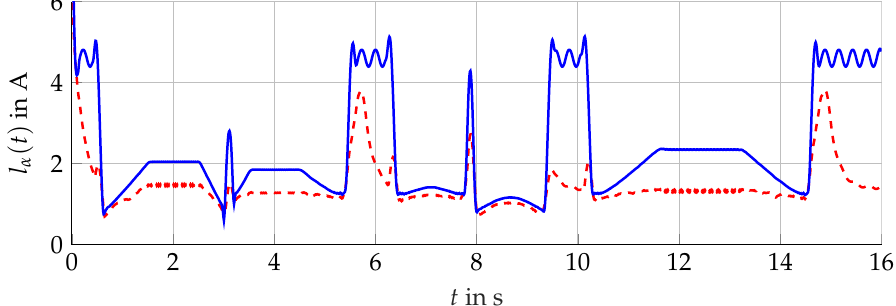
Figure 13. Interval width l α ( t ) of the bundle of observers B (red) compared with the single interval observer ∑ (blue). REF